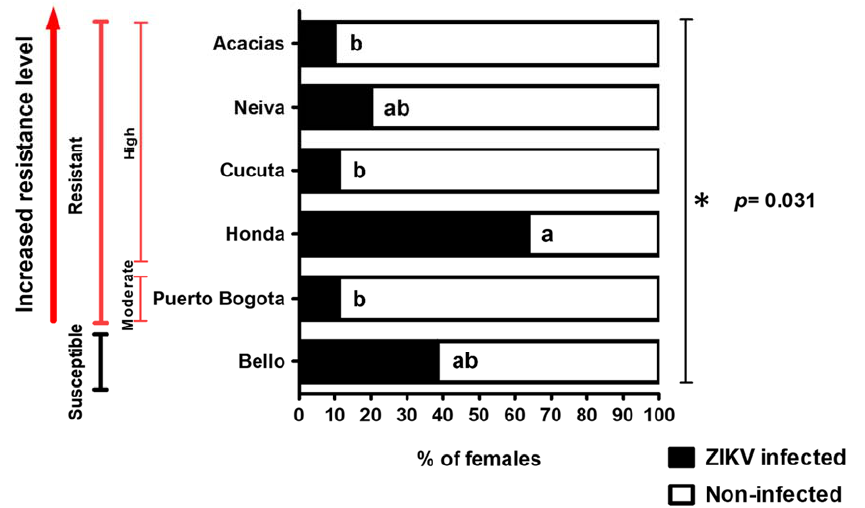
Figure 2. One-step RT-PCR determined the percentage of ZIKV-infected (black) and non-infected (white) females. There were significant differences between cities in infection status. * Chi-square ( X 2 ): 12.253 df: 5 ( p = 0.031). Bars not sharing the same letters are significantly different ( p < 0.05) in paired comparisons between cities using the Fisher’s exact test.